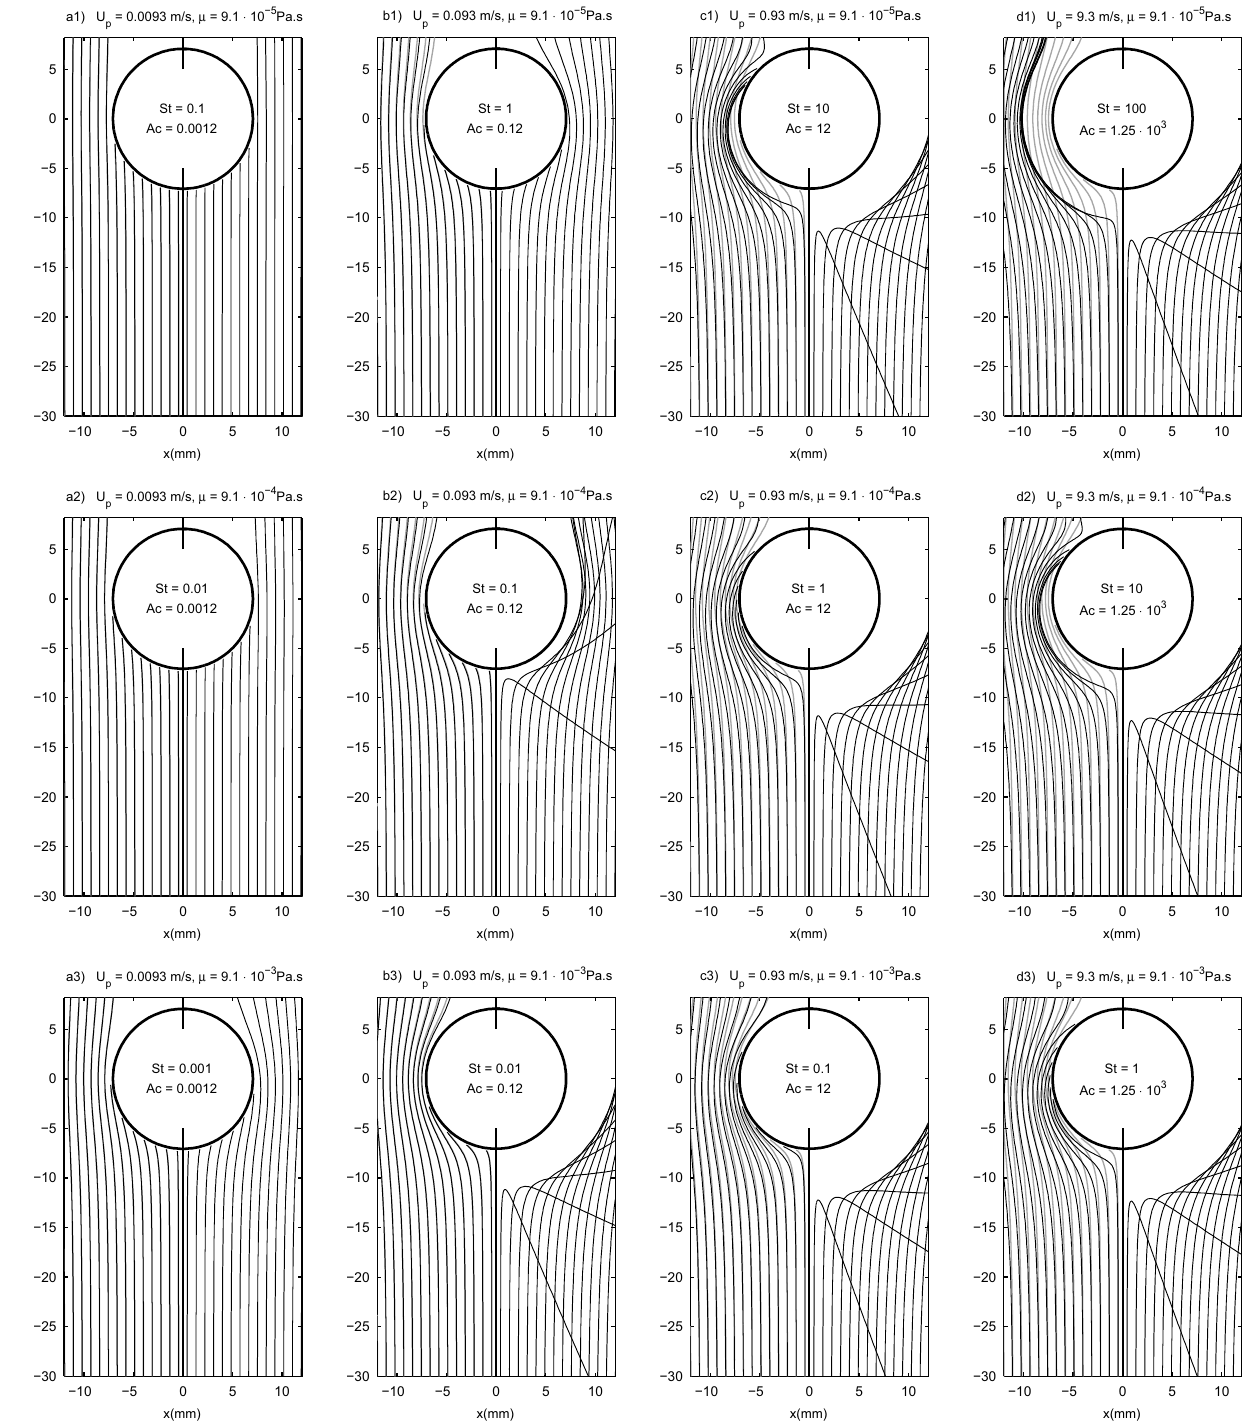
Fig. 5. Computed trajectories of 0.5 mm bubble, encountering 14.1 mm particle moving at velocity U p Each row is for a di ff erent liquid viscosity (0.091, 0.91 and 9.1 mPa · s for the first, second and third row, respectively; the first row is a rather hypothetical case). All results are for a bubble with immobile interface (e.g. contaminated with surfactants). Left halves of the trajectory map shows the results for the full model (black lines) and for the non-inertial model (gray lines, which sometimes hidden below the black lines). The right halves show the results of the inviscid